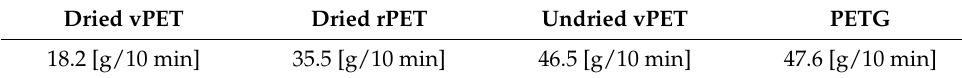
Table 4. Starting shear stresses of the relaxation test.